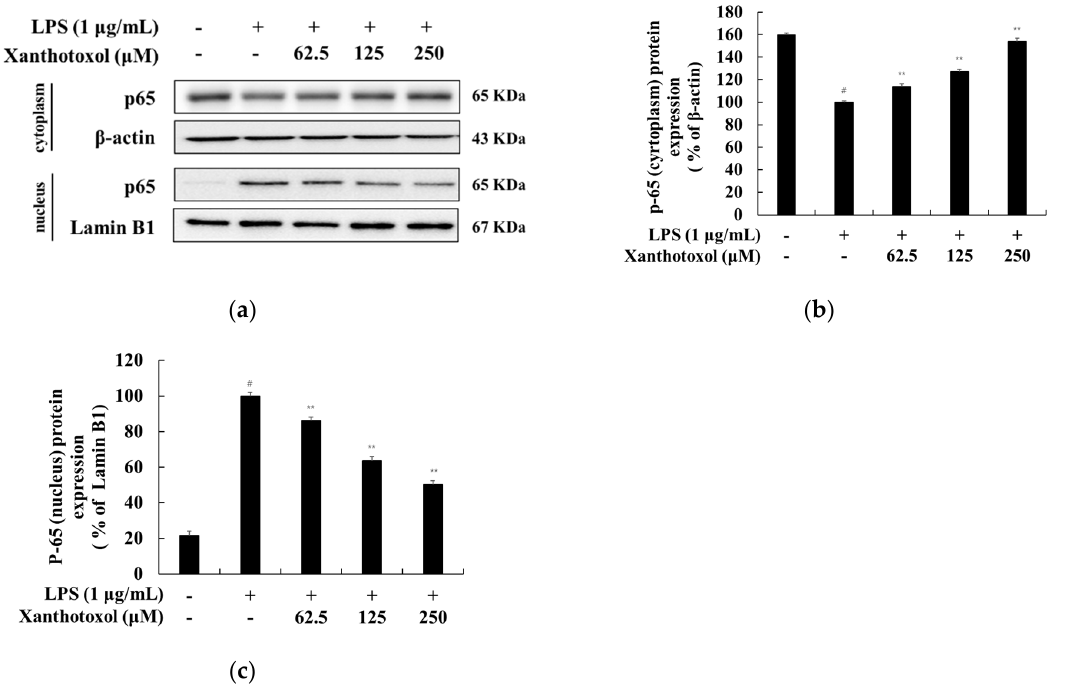
Figure 8. Effect of xanthotoxol on protein expression level of NF- κ B (p65) in LPS-induced RAW 264.7 cells. The cells were treated with xanthotoxol (62.5, 125, and 250 µ M) and LPS (1 µ g/mL)